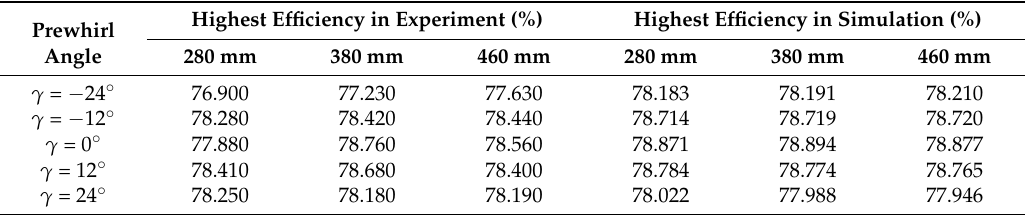
Table 6. Comparison of pump efficiency with different axial